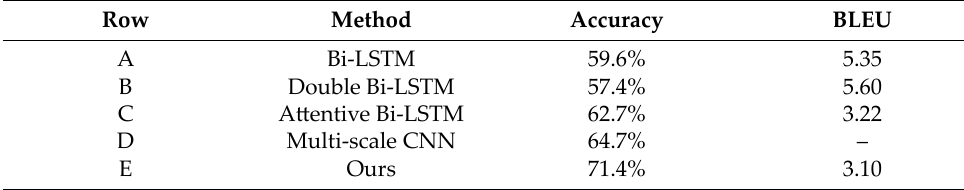
Table 6. Experimental results on Knowledge-based QA dataset.